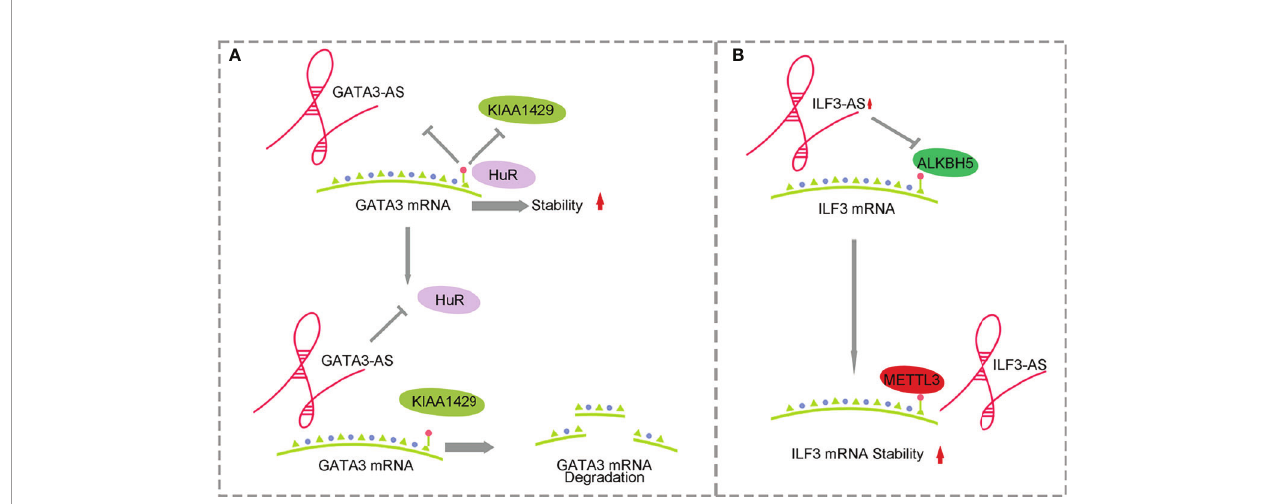
FIGURE 2 | Mechanism of antisense lncRNA and m6A methylation affecting HCC. (A) GATA3-AS with the help of methylase KIAA1429 promotes the degradation of GATA3 mRNA. (B) ILF3-AS with the help of METTL3 improves ILF3 mRNA